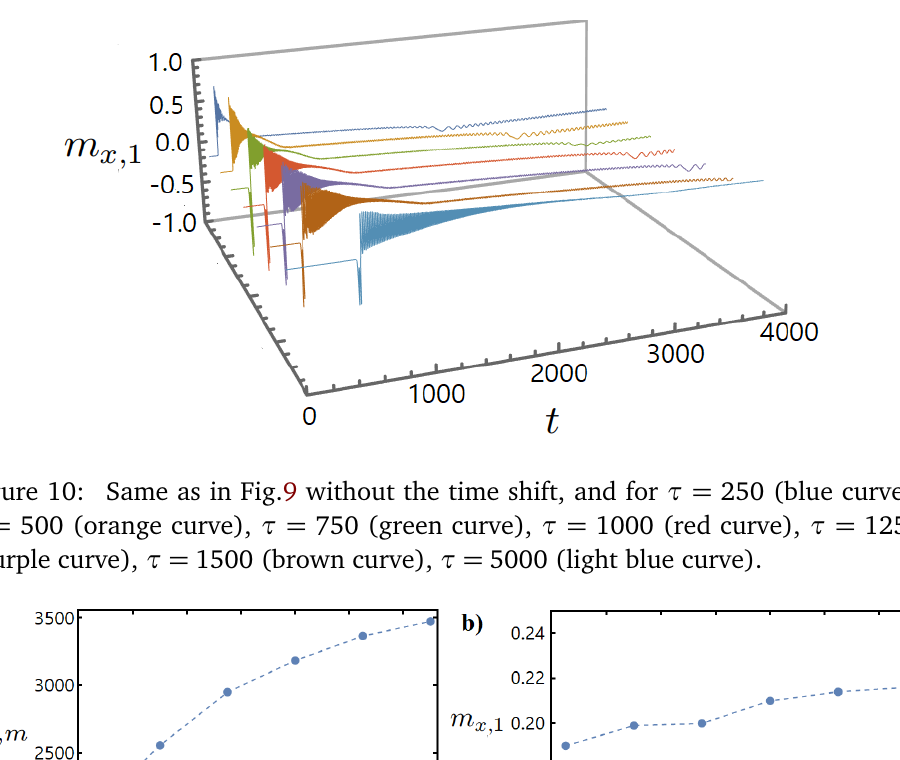
Figure 11: a) Critical time t so as to maintain constant the ’fluence’ in Eq. (28); b) order parameter m function of τ , for r = 640 and constant ’fluence’, measured at time t right after the end of the laser